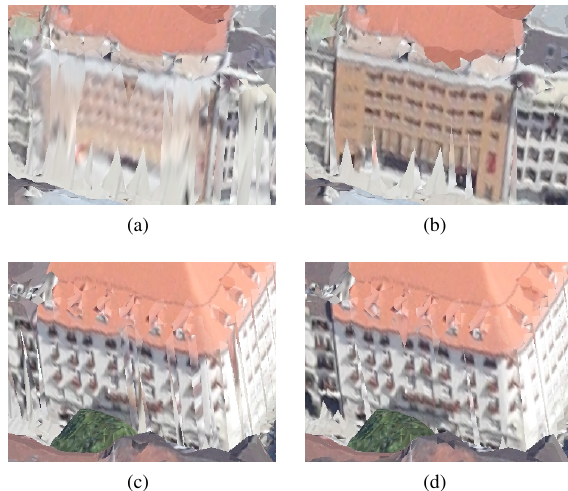
Figure 9. Selected areas of the textured city model with λ = 0.5 (using the α − β swap algorithm). (a) T = 0; (b) T = 0.1; (c) T = 0; (d) T = 0.1